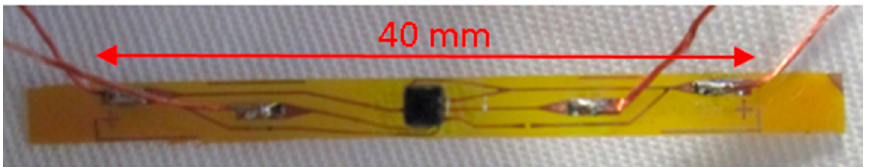
Figure 2. Completed filament circuit photograph with MC6470 and external wires soldered and encapsulated.